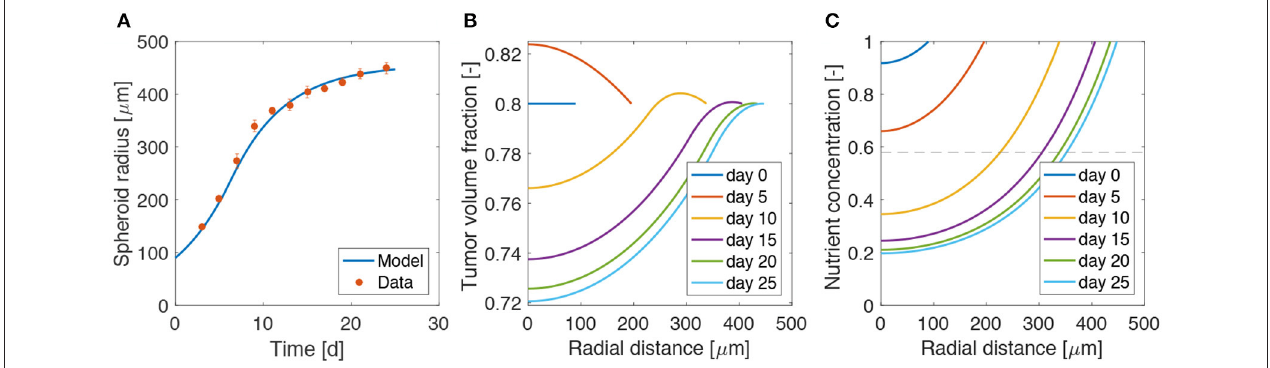
FIGURE 2 | Calibration of the model on tumor spheroid data. (A) Fit of the mathematical model to the experimental data for the spheroid growth curve. The experimental points are taken from Mascheroni et al. (2016) and represent the growth of U87 spheroids. Dots are mean values and bars standard deviation of the measurements. Tumor volume fraction (B) and oxygen concentration (C) at different times of spheroid growth. The dashed line in the last plot displays the critical oxygen concentration.